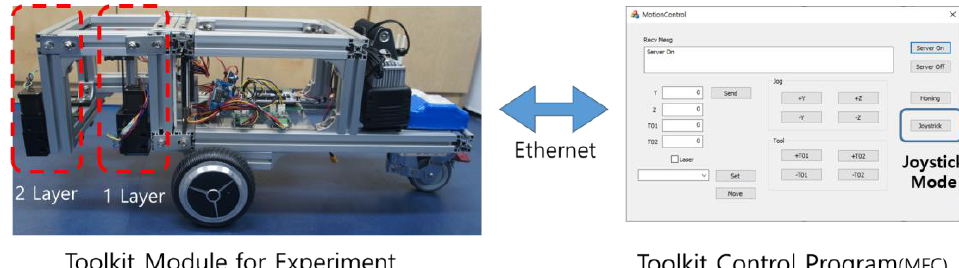
Figure 15. Multi-layout Marking Toolkit Robot for the Experimental System .